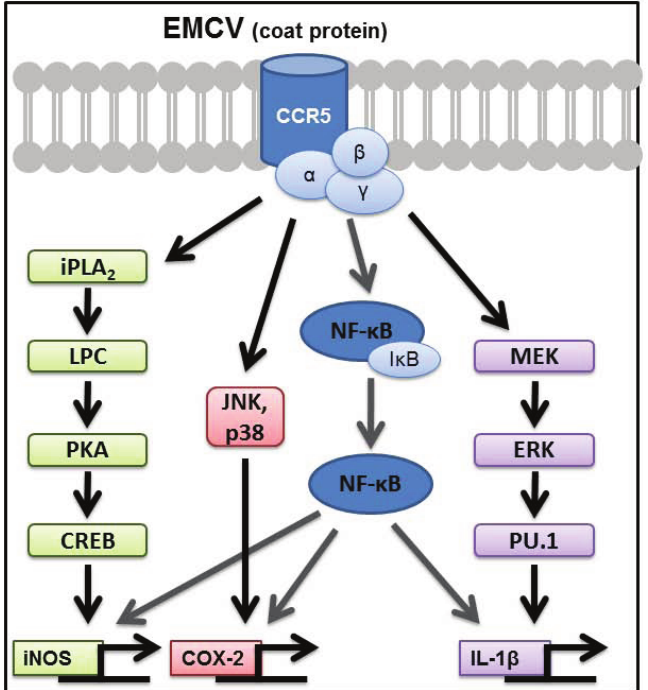
Figure 1. Signaling pathways required for encephalomyocarditis virus (EMCV) to stimulate pro-inflammatory gene expression in macrophages. The EMCV coat protein, devoid of viral RNA, activates CCR5-dependent signaling in macrophages within minutes of